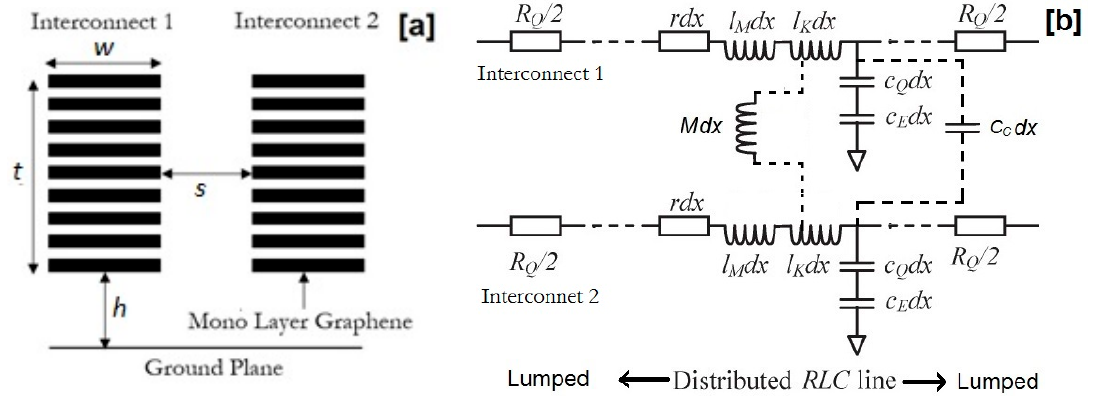
Figure 22. ( a ) Schematic of coupled MLGNR interconnects on a ground plane; ( b ) equivalent RLC interconnect lines showing coupling capacitor ( C c dx ) and inductor ( Mdx ) [77,80].